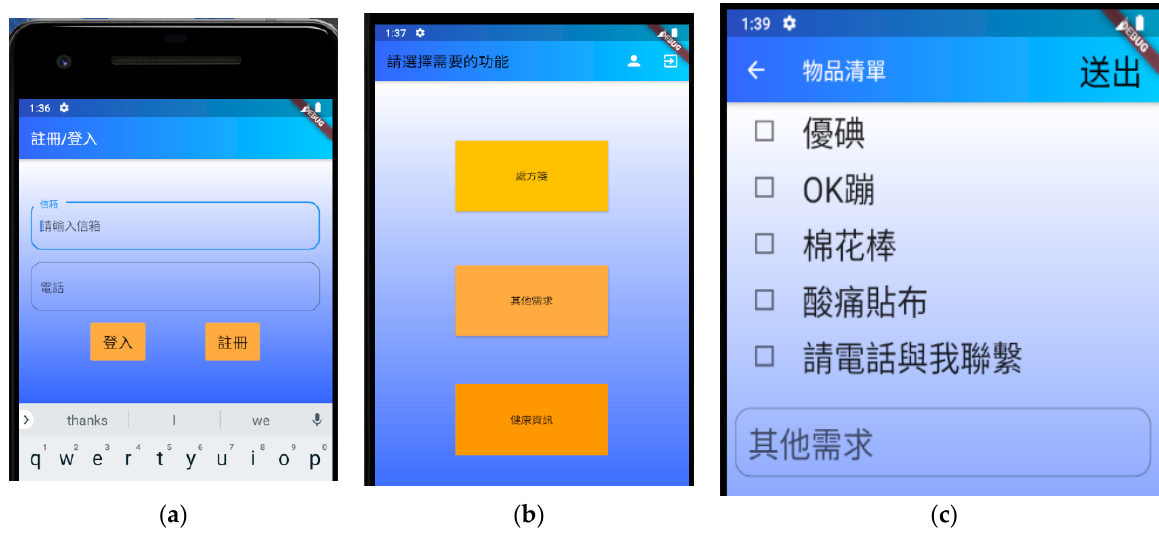
Figure 2. Key factors supporting the new model.